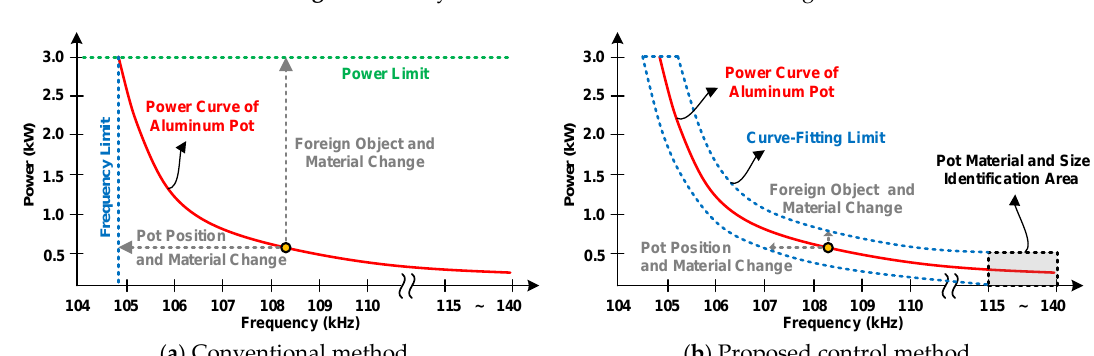
Figure 8. Control algorithm strategy of the IH system.